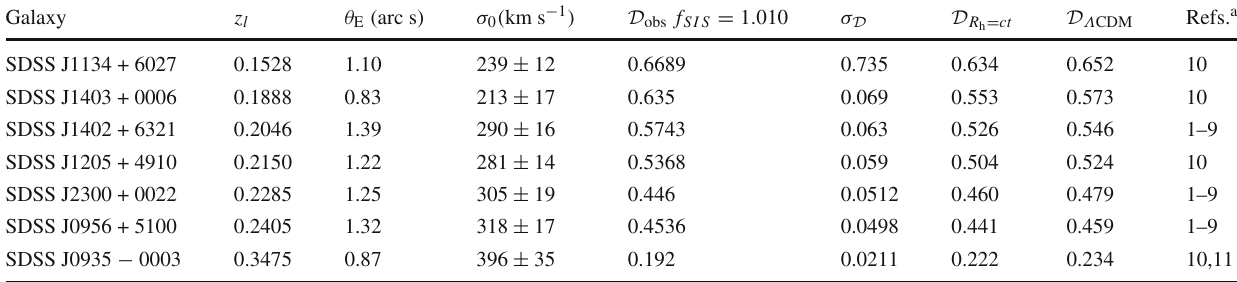
Table 2 Strong gravitational lensing systems with 0 . 46 < z s < 0 . 485